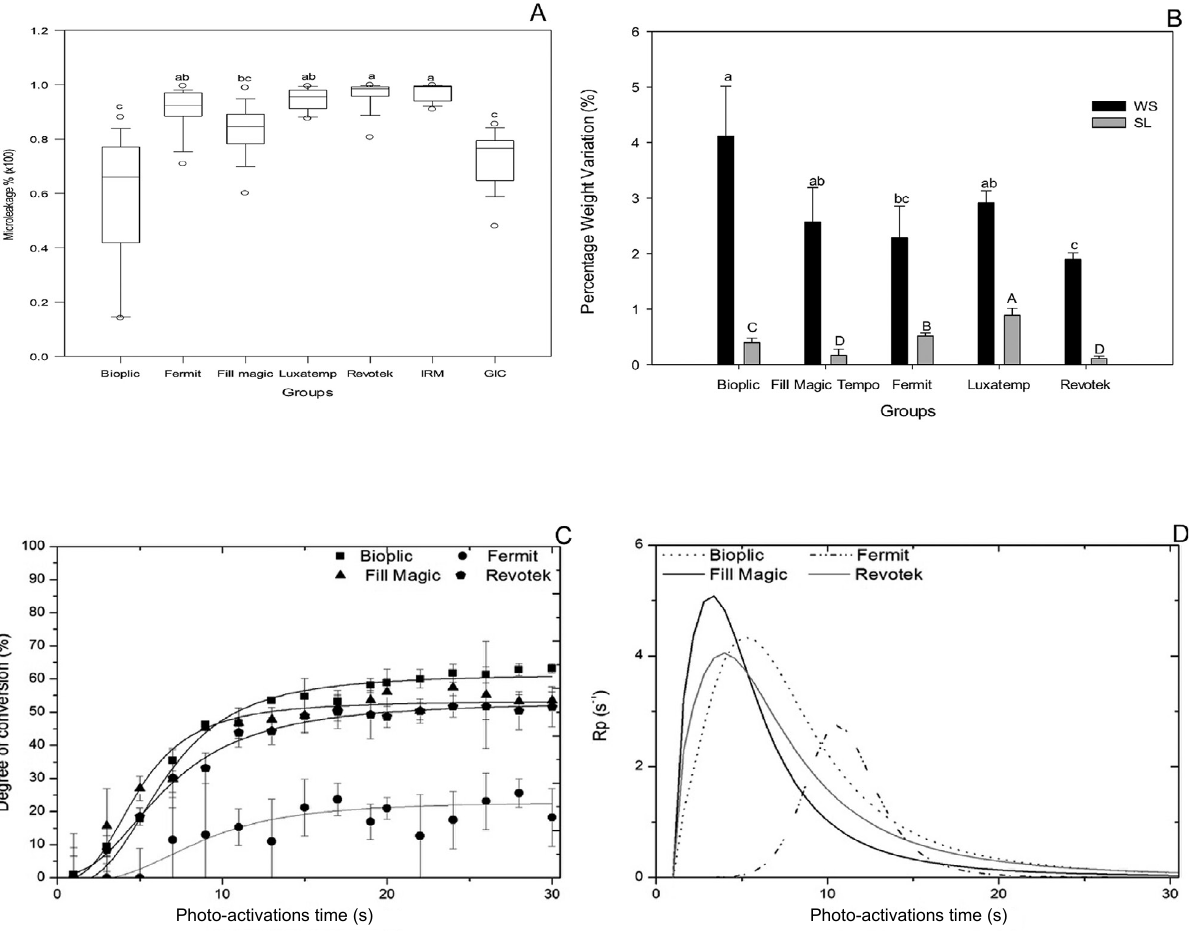
Figure 2- (A) Microleakage after 1000 cycles, (B) water sorption and solubility expressed in %wt, (C) Degree of conversion and (D) Polymerization rate Pr-1 of materials tested. Different letters represent statistically significant differences between groups